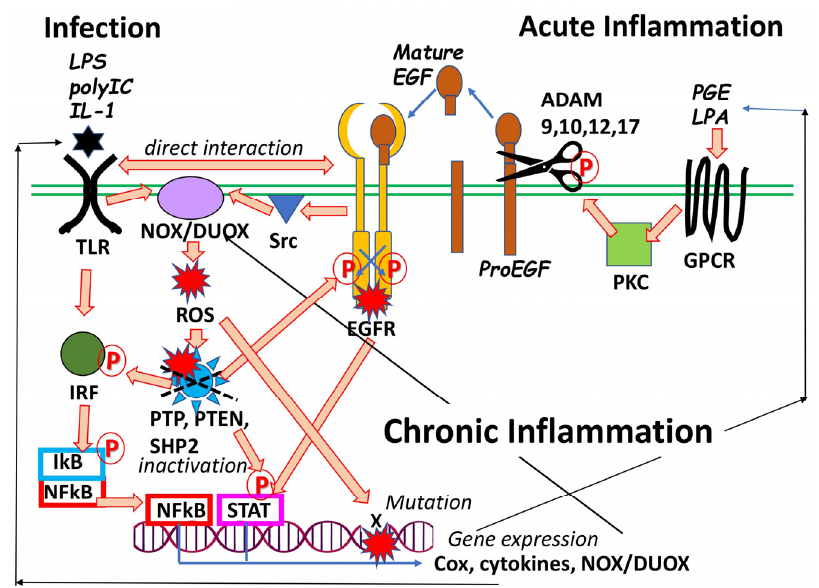
Figure 2. Interaction between Toll-like receptor (TLR) and EGF receptor tyrosine kinase (EGFR/ErbB1) in chronic inflammation and carcinogenesis. Many reports confirm the contribution of EGFR signaling to TLR-mediated chronic inflammation [37,38]. In addition, other studies indicate the requirement of EGFR in the TLR signaling itself [22–24]. EGFR signaling induces NADPH oxidase (NOX) activation resulting in the production of reactive oxygen species (ROS) and hydrogen peroxide, which inactivate protein phosphatases (SHP2, PTP1B, PTEN, etc.), elevating basal phosphorylation (P) or enhancing induced phosphorylation (P) of adaptor or signaling molecules: IRF, IkB, STAT, MAP, etc. Alternatively, ROS reacts with DNA, producing DNA mutation and leading to carcinogenesis. Elevation of their phosphorylation results in the DNA binding of NFkB, STAT, and AP-1 [39], leading to cell proliferation and gene expression of NOX, cyclooxygenase (COX), and cytokines and worsening inflammation. These promote the production of prostaglandins (PGE) and lysophosphatidic acid (LPA), which bind to their receptors of G-protein-coupled receptors (GPCRs). Activated protein kinase C (PKC) transactivates metalloproteases in a disintegrin and metalloprotease (ADAM) 9, 10, 12, or 17 [40,41]. ADAM cleaves the membrane-anchored EGF precursor or precursors of other members of the EGF family such as HB-EGF and TGF α and liberates mature EGF or its homolog, activating EGFR. These feed-forward and feed-back interactions between TLR and EGFR are implicated in the pathogenesis of chronic inflammation as well as in carcinogenesis.